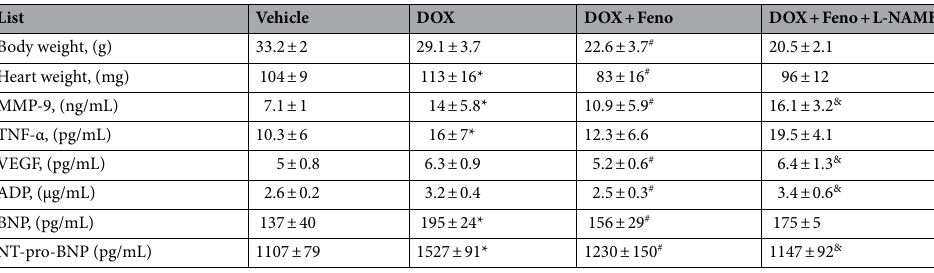
Table 1. Serum parameters in wild-type FVB/NJ mice after 9 weeks of dietary treatment. Values are the mean ± standard deviation (SD). *P < 0.05, for DOX versus vehicle; # P < 0.05, for DOX + Feno versus DOX, & P < 0.05, for DOX + Feno + L-NAME versus DOX. DOX: doxorubicin, Feno: fenofibrate, L-NAME: N G - nitro-L-arginine methyl ester, MMP-9: matrix metallopeptidase 9; TNF-α: tumor necrosis factor alpha, VEGF: vascular endothelial growth factor, ADP: adiponectin, BNP: brain natriuretic peptide, NT Pro-BNP: N-terminal pro-brain natriuretic